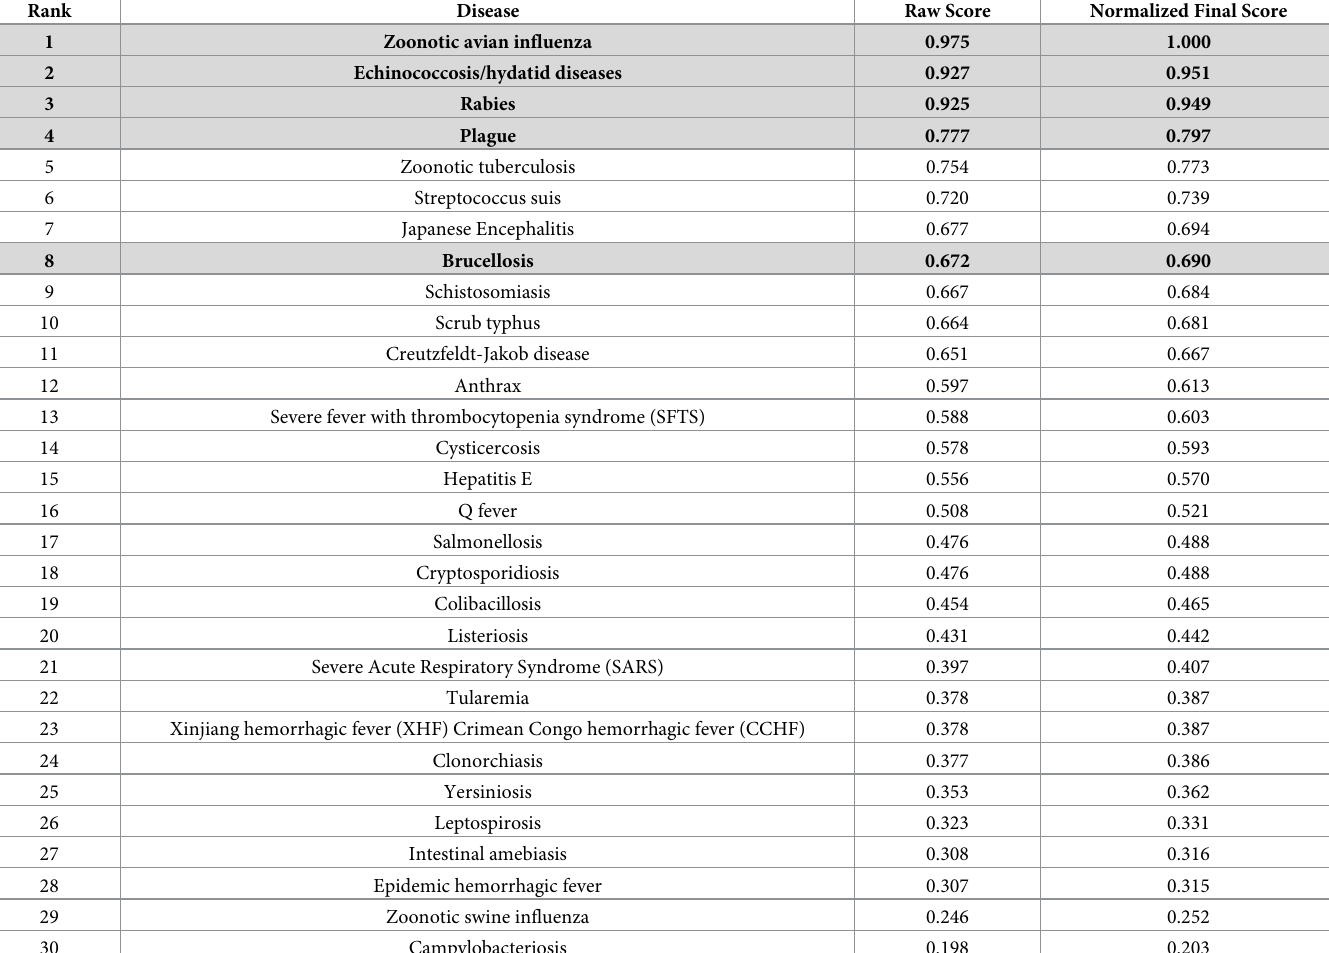
Table 2. Raw and normalized scores for 30 zoonotic diseases generated from the One Health Zoonotic Disease Prioritization (OHZDP) tool during the OHZDP workshop, Beijing, China, May 15–17, 2019. The top five priority zoonotic diseases selected by voting members are highlighted in grey and bolded.